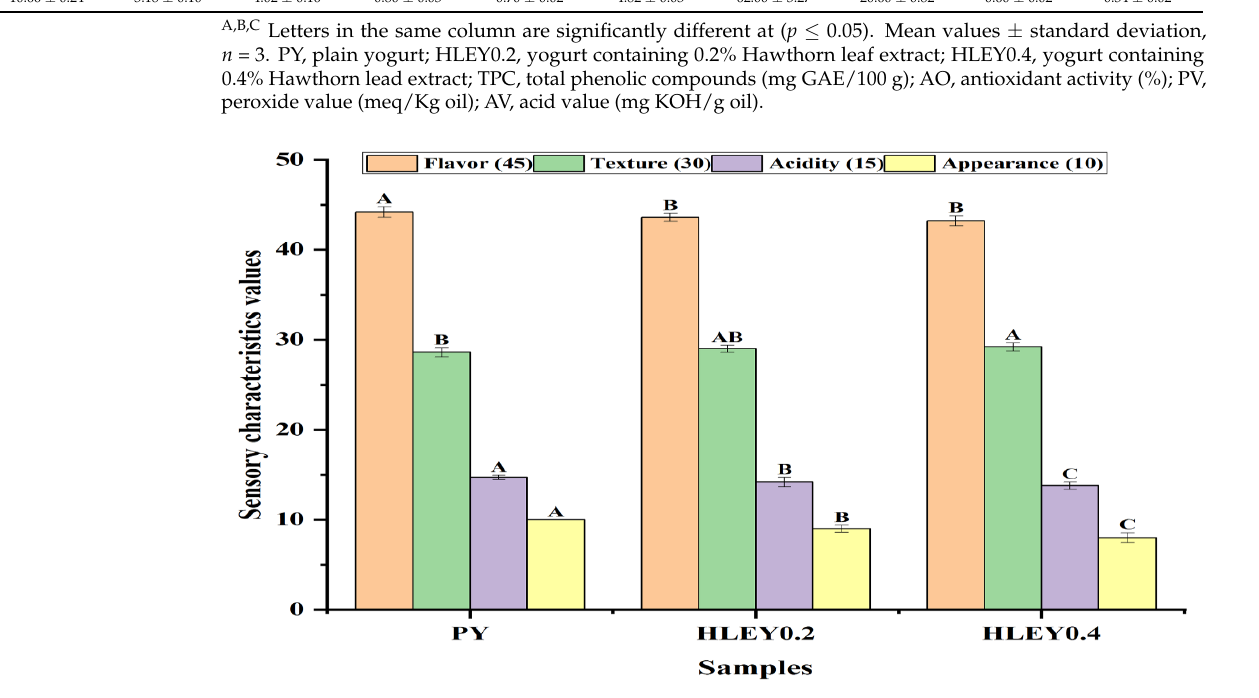
Table 1. Chemical compositions and physicochemical characteristics of yogurt fortified with aque- ous Hawthorn leaf extract.